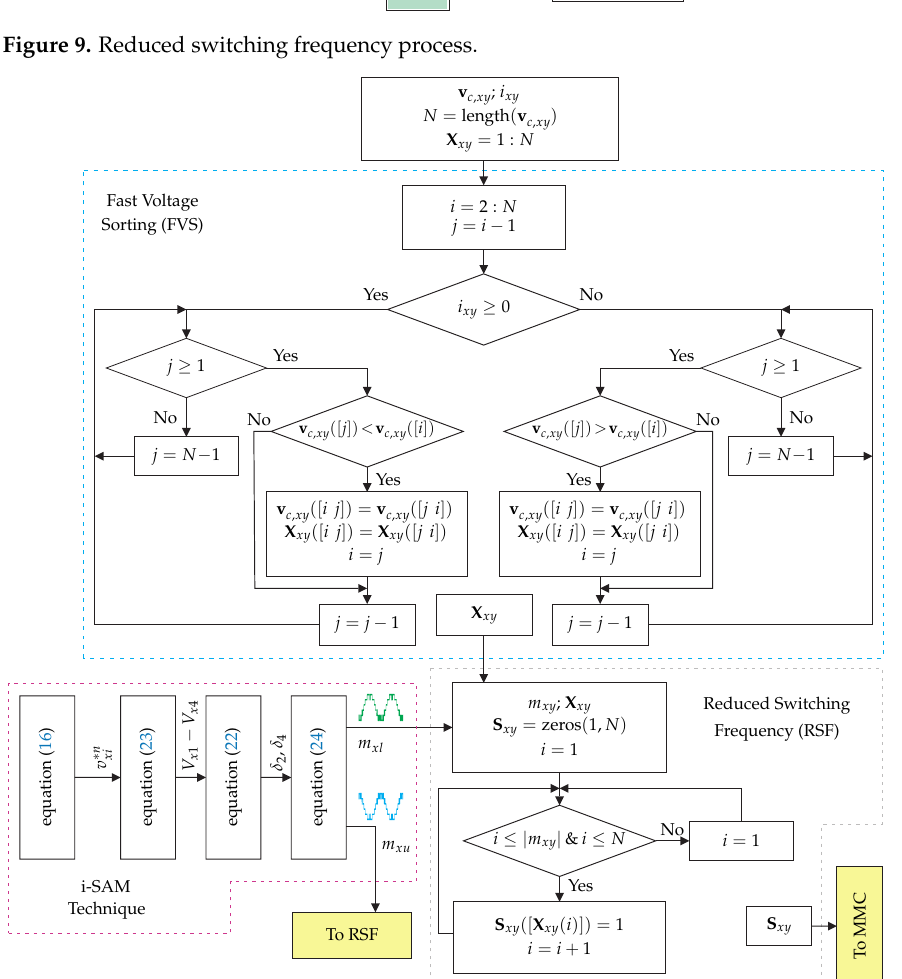
Figure 10. General submodule voltage balancing algorithm